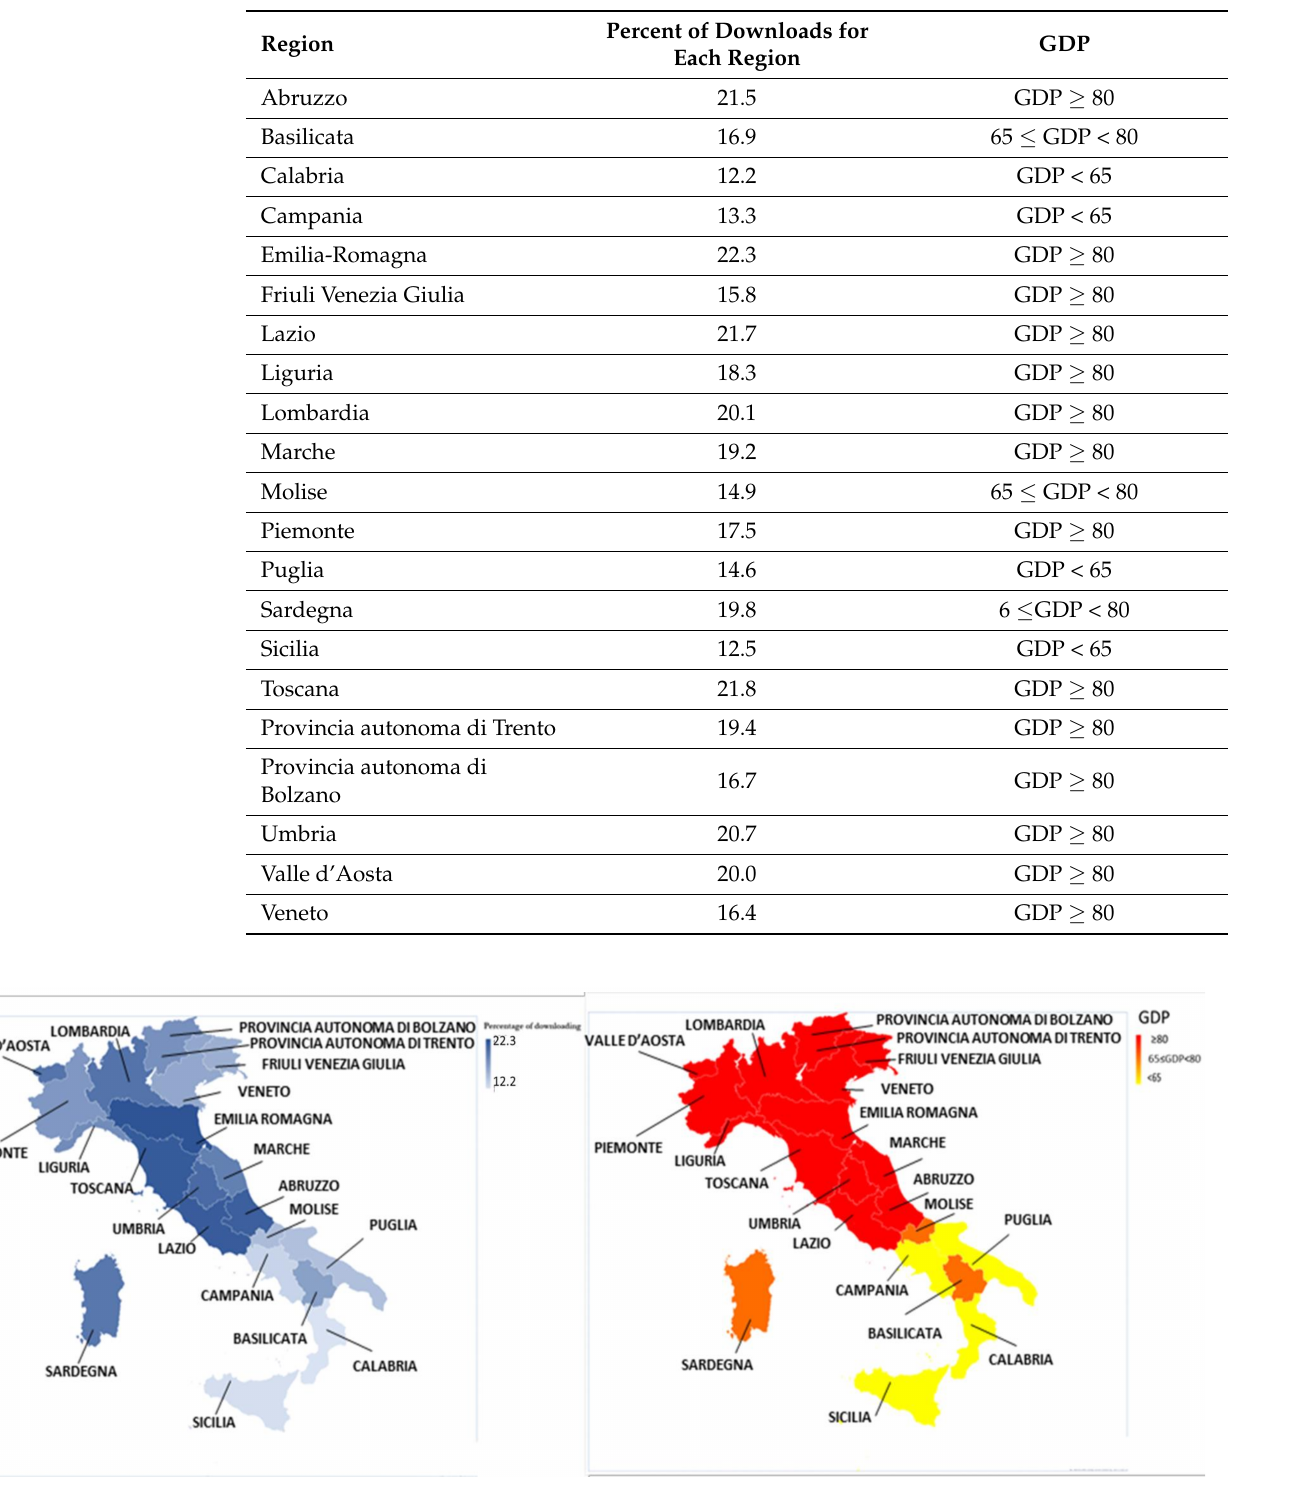
Figure 2. Graphic representation of percent of downloads for each region and